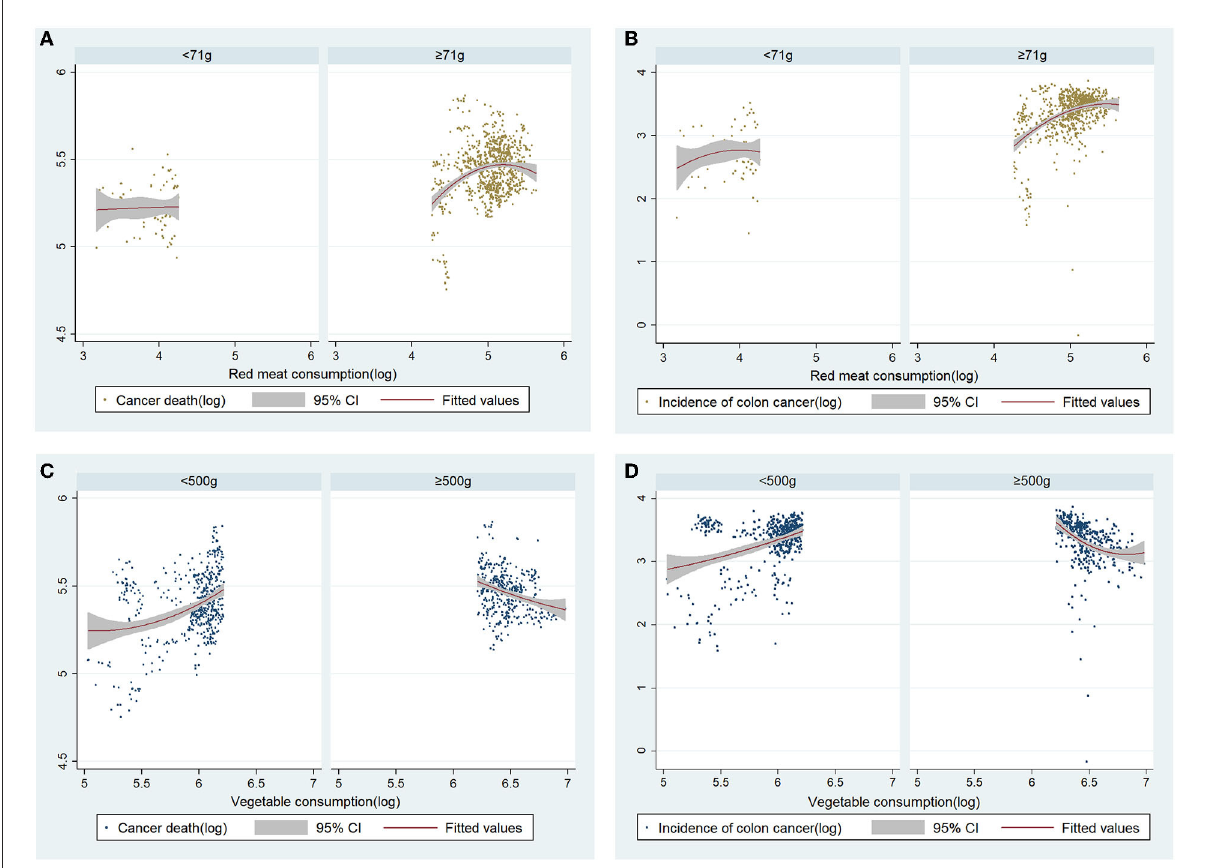
FIGURE1 Correlation between red meat consumption, cancer death, and incidence of colon cancer; sub-group analysis by a recommended allowance of red meat a day (71 grams). Scatter plots and quadratic curves for red meat consumption and (A) cancer death, and (B) incidence of colon cancer. All variables were converted to natural logarithms. Correlation between vegetable consumption, cancer death, and incidence of colon cancer; sub-group analysis by recommended vegetable requirements a day (500 grams). Scatter plots and quadratic curves for vegetable consumption, (C) cancer death, and (D) incidence of colon cancer. All variables were converted to natural